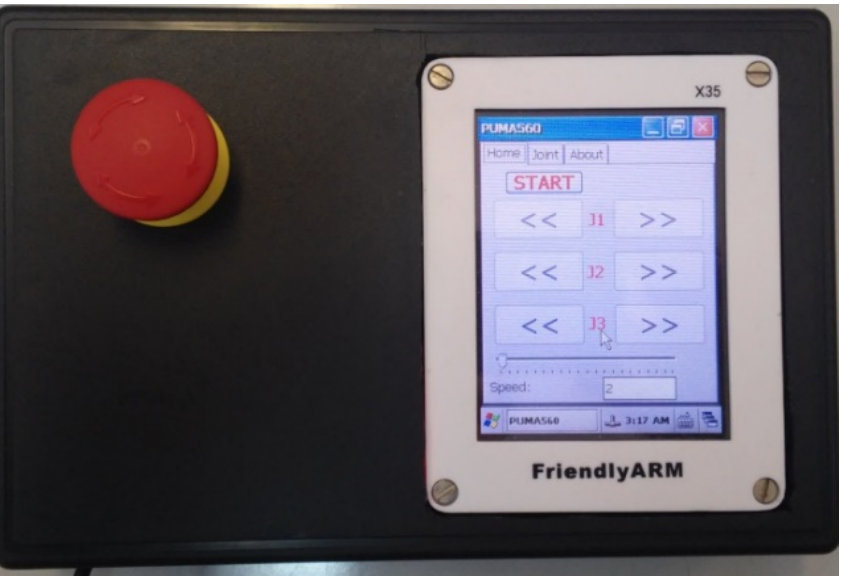
Figure 7. Teach pendant based on Friendly ARM 2440.